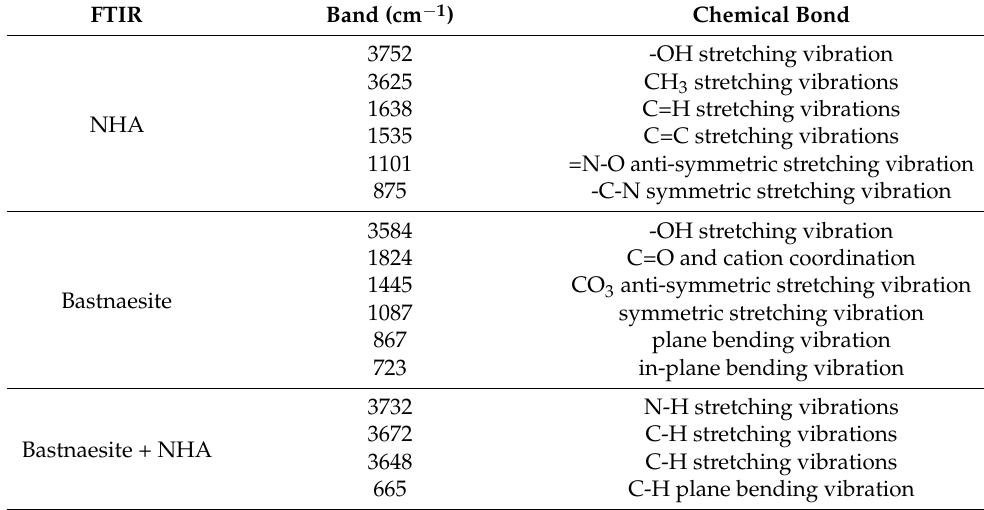
Figure 6. FTIR spectra of pure, 2-OH-3-NHA-treated bastnaesite ( a ) and pure, 2-OH-3-NHA-treated calcite ( b ). Table 5. The bands corresponding to the relevant chemical bond in FTIR spectra of the minerals. FTIR